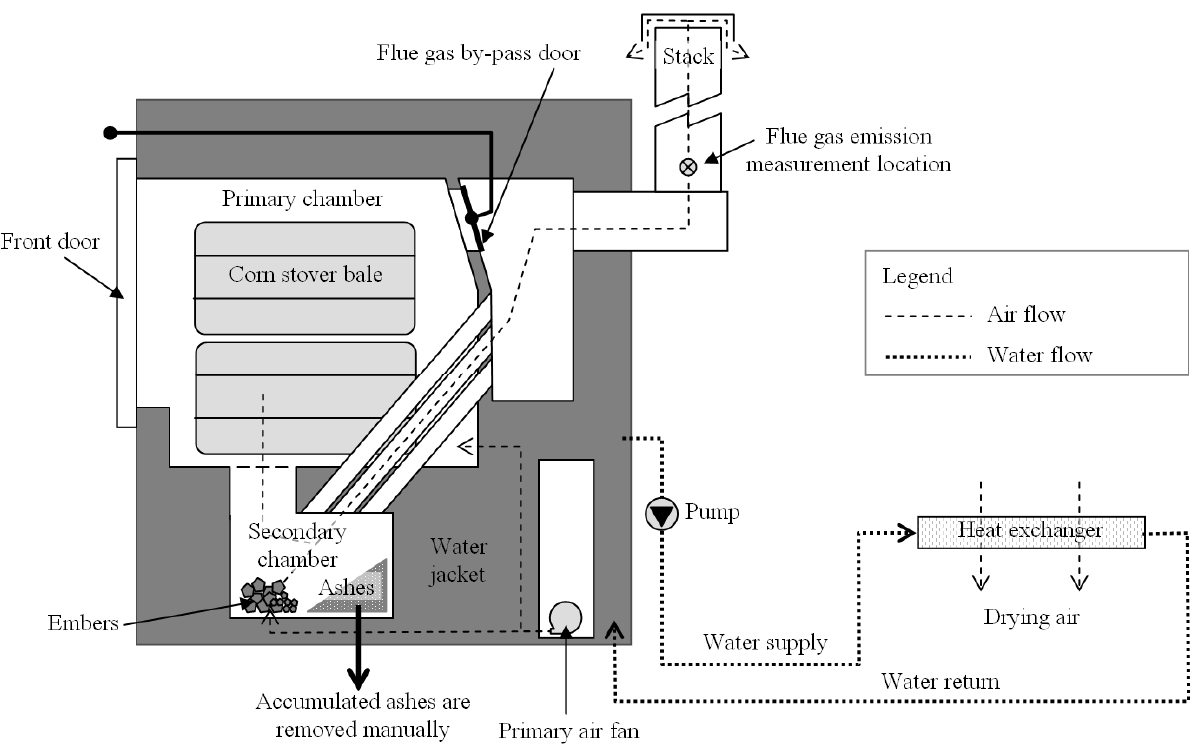
Figure 1. Schematic of the 146-kW boiler with heat exchanger